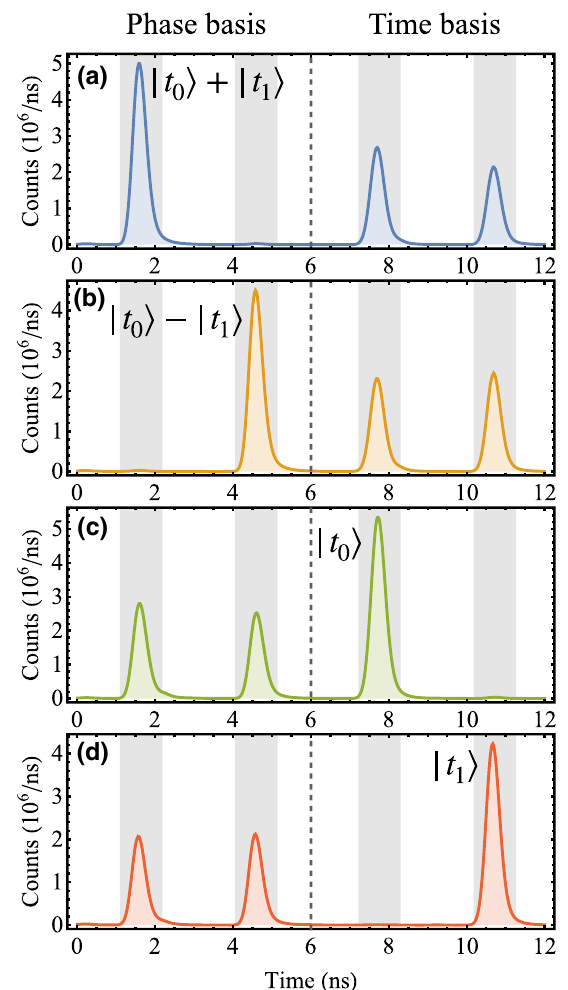
FIG. 3. Time-bin states measurement. (a),(b) Phase-basis mea- surement: the single-photon data. (c),(d) Time-basis mea- surement: the shaded area represents the temporal window corresponding to each time-bin state. The number of counts shown is taken for an integration time of 1 s. The gray dotted line shows the separation between the phase basis and the time